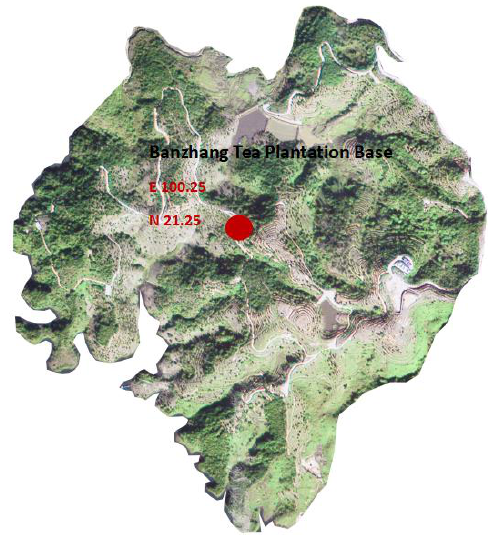
Figure 1. Location of the study area.